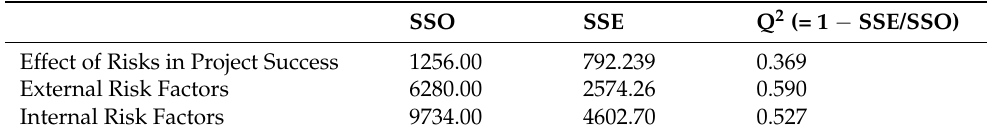
Table 14. Results of predictive relevance (Q 2 )